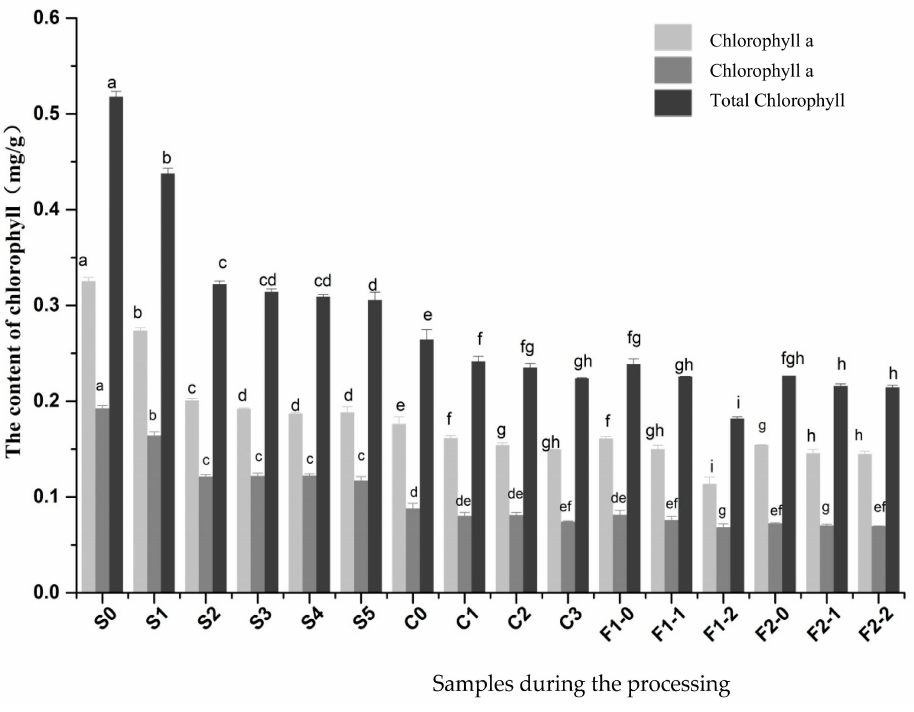
Figure 5. Chlorophyll content of pepper samples prepared by four different methods. Different letters (a, b, c, and so on) on the columns indicate significant differences between the samples ( p < 0.05). Data are expressed as means ± standard error of mean. The meaning of S0, S1, and other samples are provided in Table